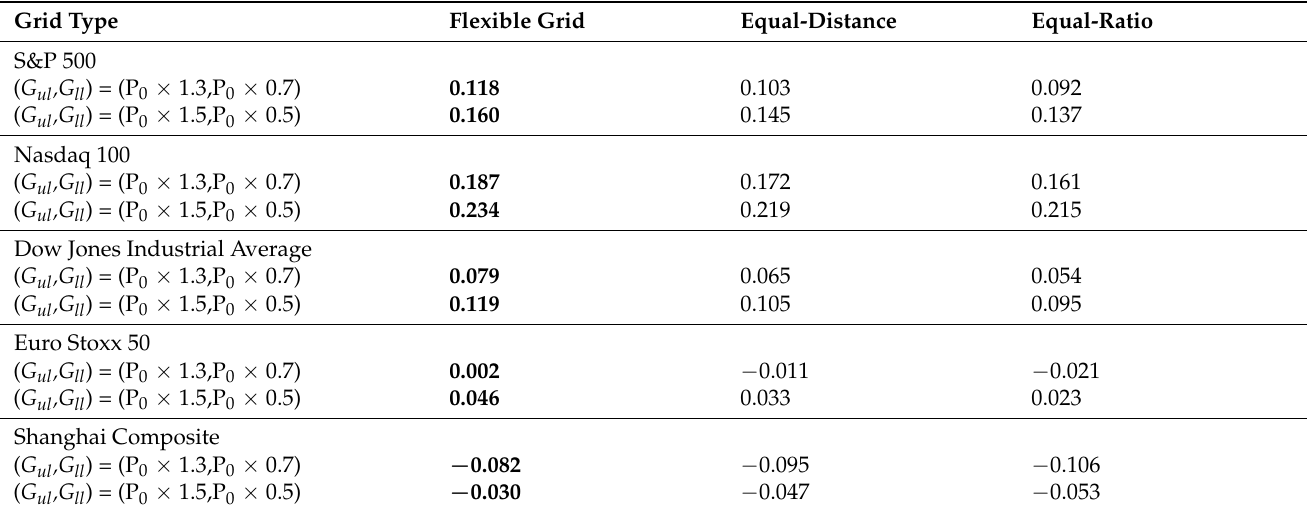
Table 5. Sharpe ratio obtained by flexible grid, equal-distance grid, and equal-ratio